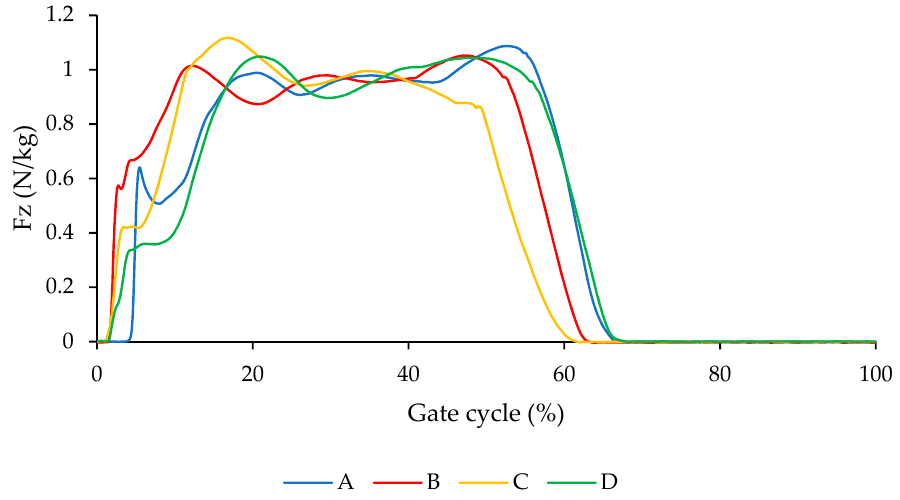
Figure 14. Fz (vertical component of ground reaction force (GRF)) for conditions (A) subject with bare foot; (B) subject wearing conventional HAFO with no spring; (C) subject wearing conventional Stainless Steel-based HAFO; and (D) subject wearing NiTi spring-based HAFO. (Case І ).